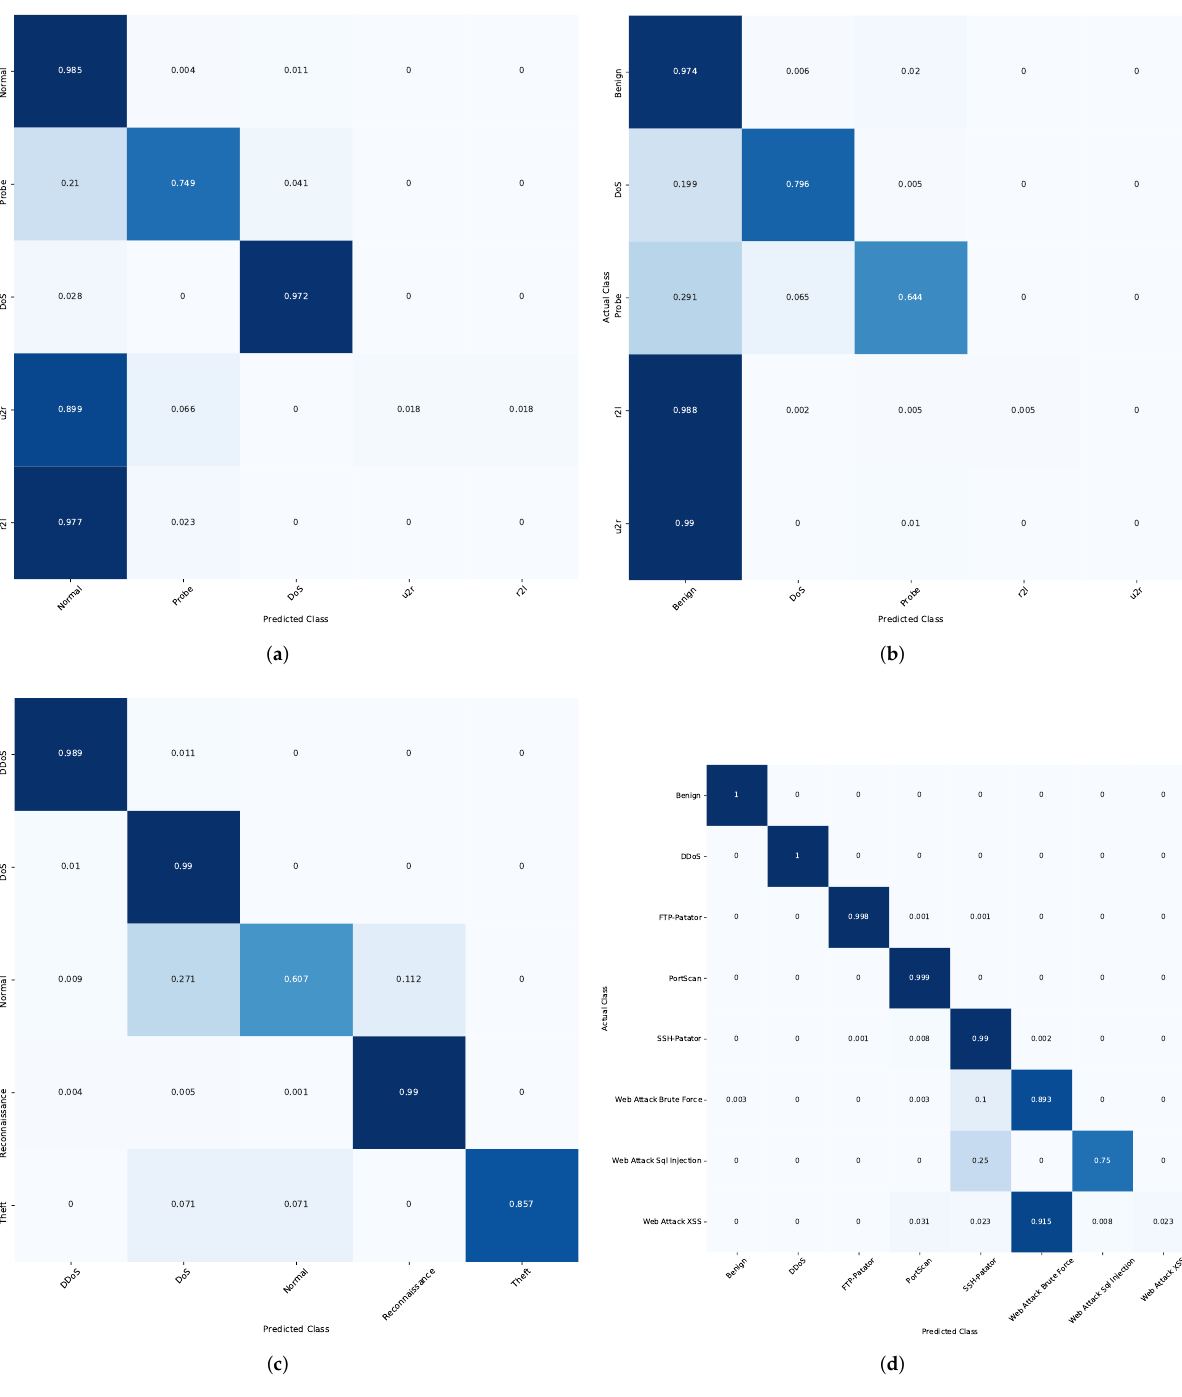
Figure 9. Confusion Matrix of developed method. ( a ) KDDCup99, ( b ) NSL-KDD, ( c ) BoT-IoT, ( d )